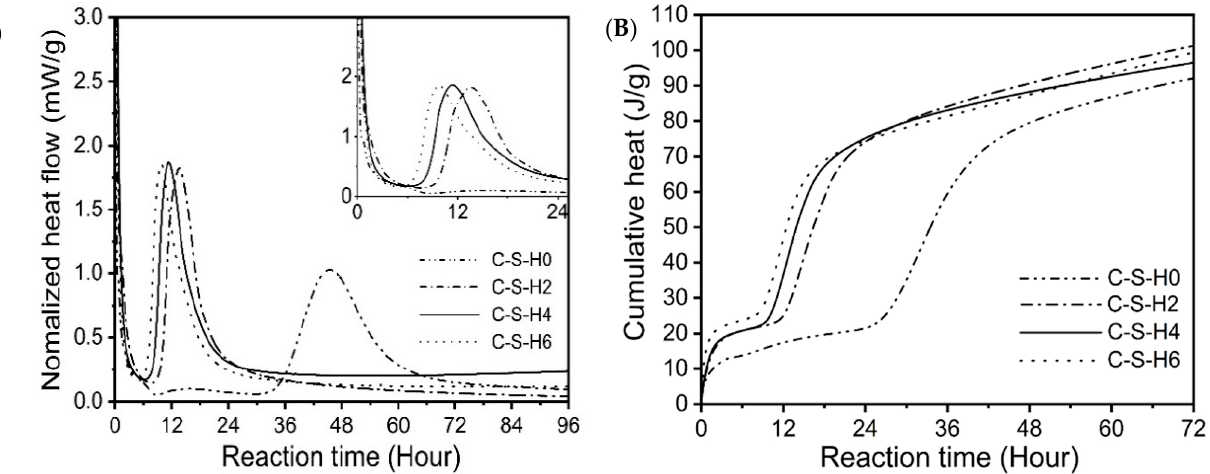
Figure 4. Heat release of samples with different dosages of C-S-H seeds: ( A ) normalized heat flow and ( B ) cumulative heat.